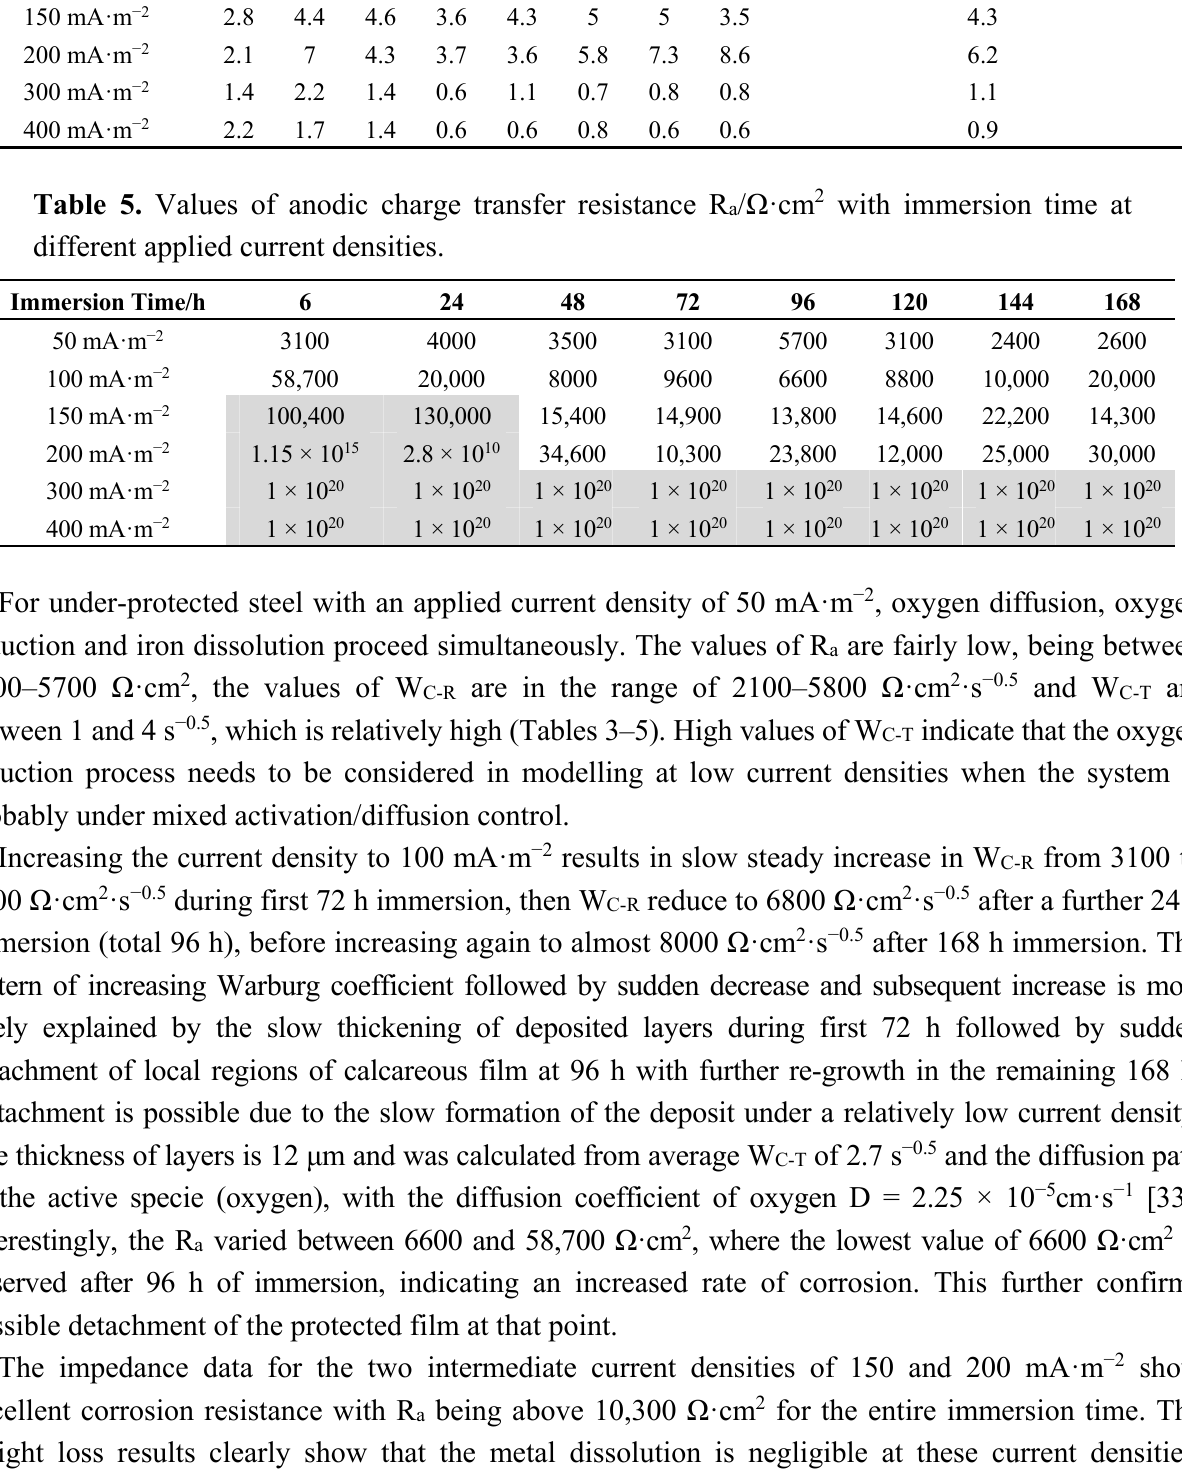
Table 4. Values of W C-T /s − 0.5 with immersion time at different applied current densities. Immersion Time/h